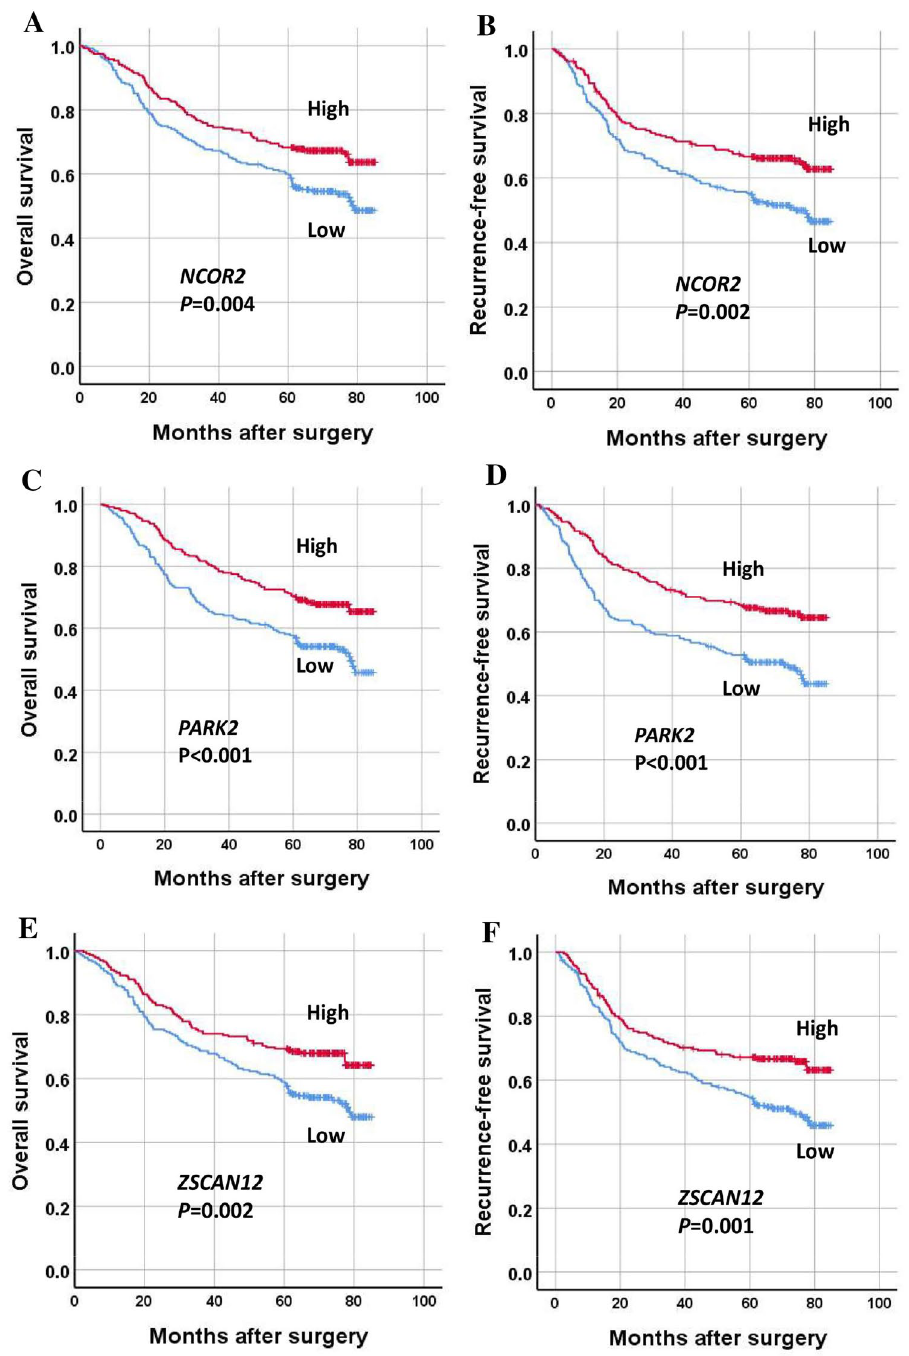
Figure 5. Survival of gastric cancer patients according to methylation status of three DNA methylation markers ( NCOR2 , PARK2 , ZSCAN12 ). Low and high methylation statuses indicate below and above the median values, respectively. Overall survival ( A , C , E ) and recurrence-free survival ( B , D , F